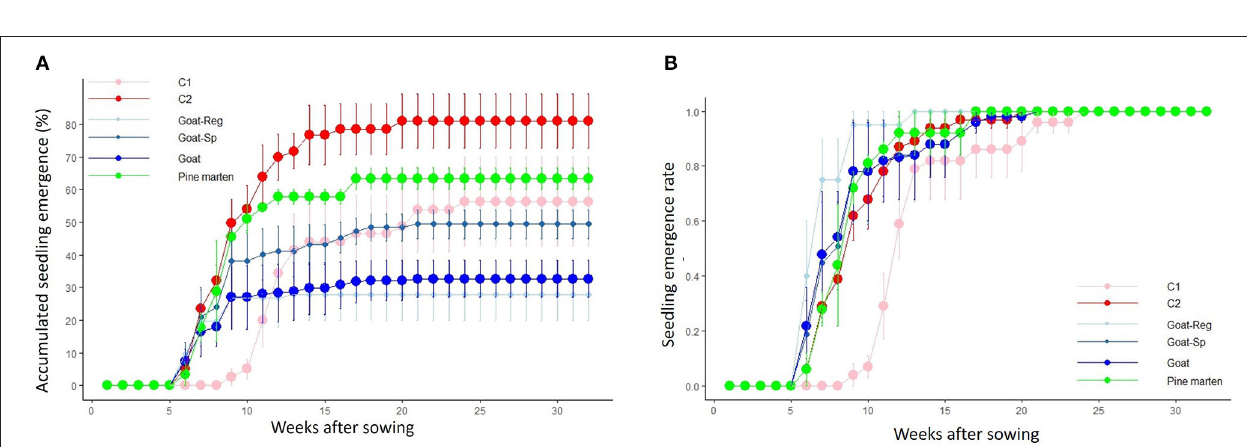
FIGURE 5 | (A) Cumulative percentages (mean ± SE) of seedling emergence (i.e., emergence success) for the five treatments, adding the net percentages for the goat, over the weeks after sowing. (B) Emergence rate, i.e., emerged seedlings each week divided by the total emerged seedlings, for the five treatments over the weeks after sowing. Pink line, C1 or “control seeds with pulp”; red line, C2 or “manually-depulped control seeds”; light blue line, seeds regurgitated by goats; dark blue line, seeds spit out by goats; blue line, seeds dispersed by goats; and green line, pine marten-ingested seeds.